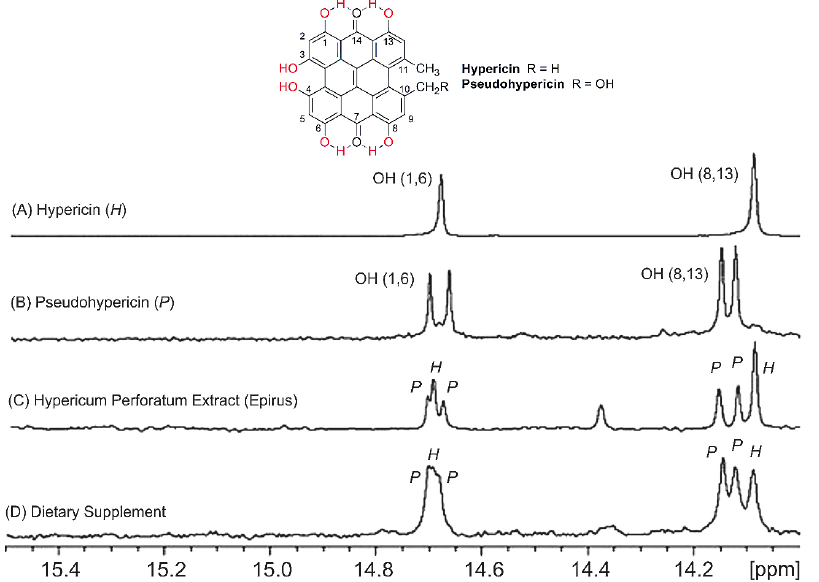
Figure 25. Selected region of 400 MHz 1 H-NMR spectra of ( A ) hypericin; ( B ) pseudohypericin; ( C ) Hypericum perforatum extract with plant material from